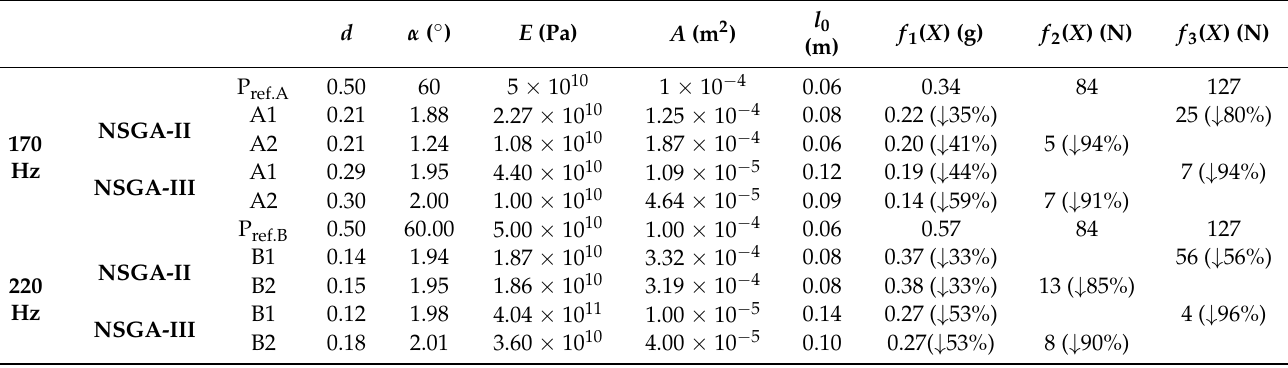
Table A1. Comparison of optimization